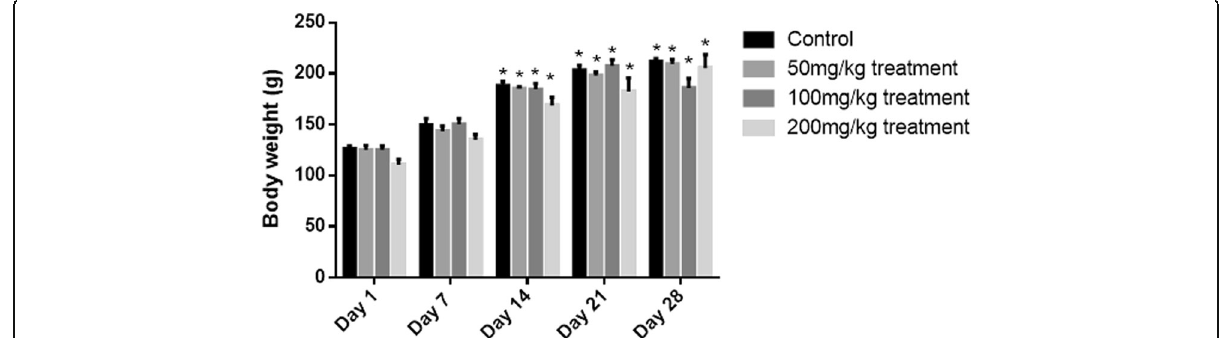
Fig. 1 Body weight variation of control and treated male rats during sub-acute toxicity studies. The data is presented as mean ± SEM. Two-way ANOVA was used for multiple comparisons by applying Dunnett's test and the weights of all the groups were compared with their relevant weight on Day 1. * represents significance of p < 0.05